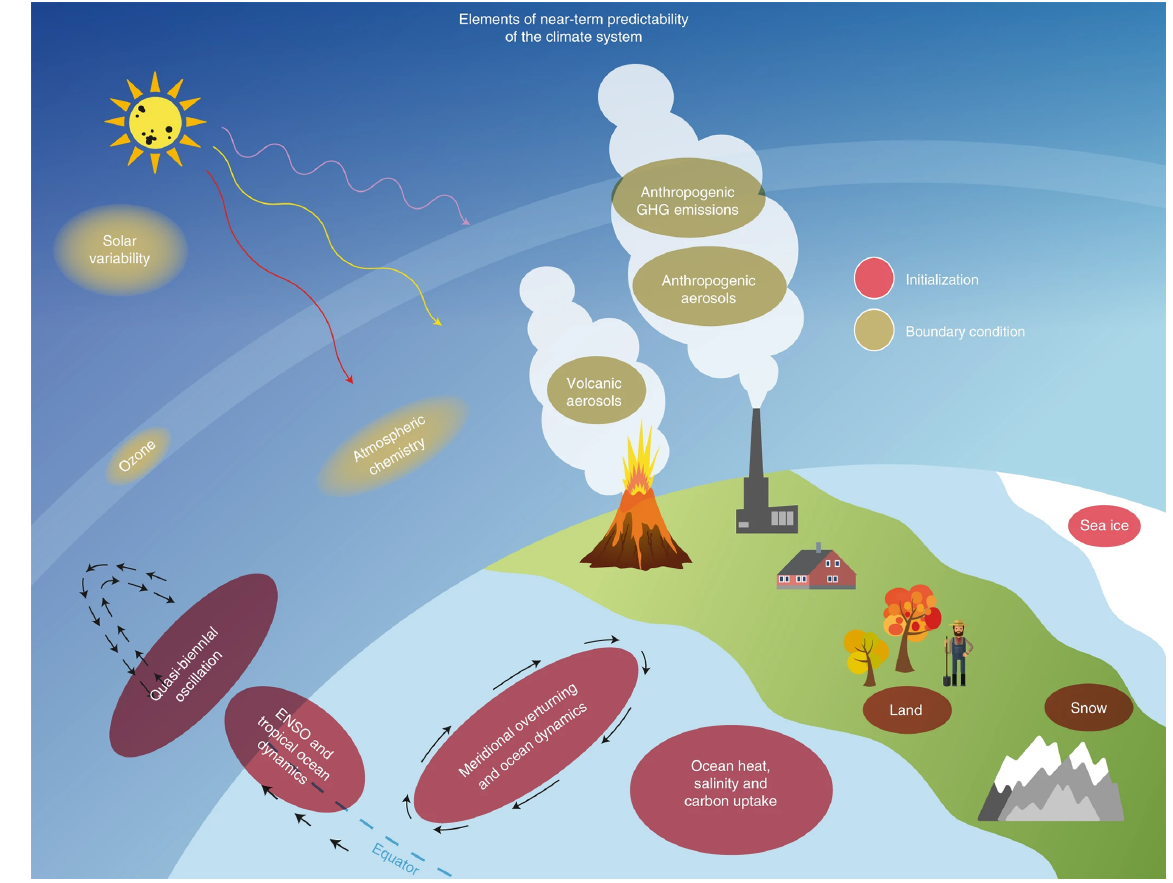
Figure 3. Sources of annual-to-decadal predictability, some of which involve the stratosphere through the response to external forcing, internal atmospheric dynamics, or ozone chemistry changes. After Kushnir et al.